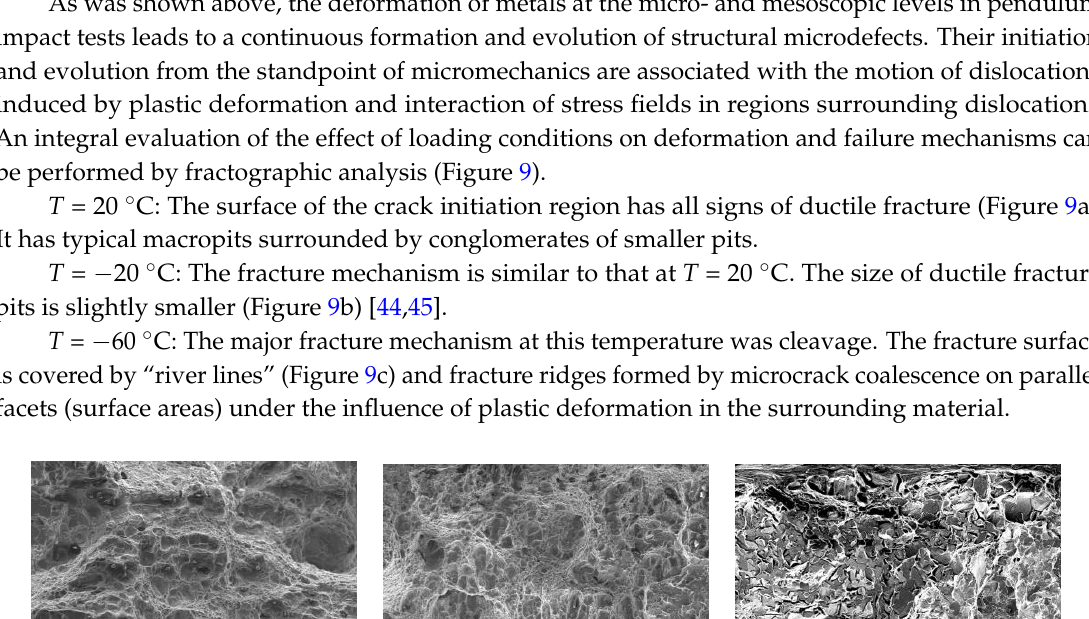
Figure 8. Distribution of the accumulated angle of local material rotation 22 zx on specimen faces at different temperatures at 500 μs after the start of loading: ( a ) −60 °C; ( b ) −20 °C; ( c ) 20 °C; ( d ) color legend.